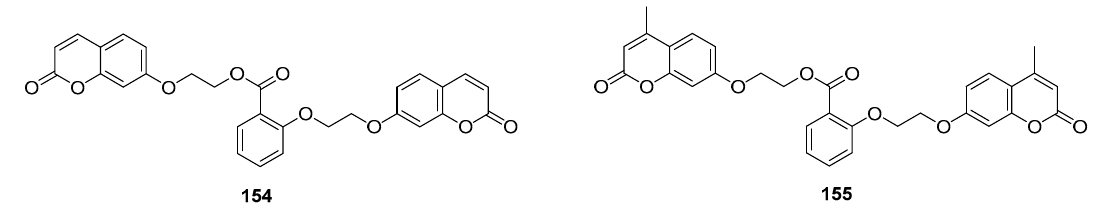
Figure 51. Chemical structure of coumarins conjugated with salicylic acid.